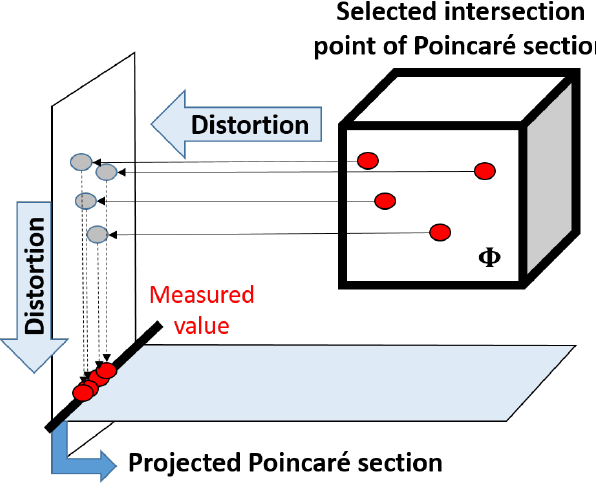
Figure 4. Effect of projection of three-dimensional intersection points in Poincaré section of fourth-order